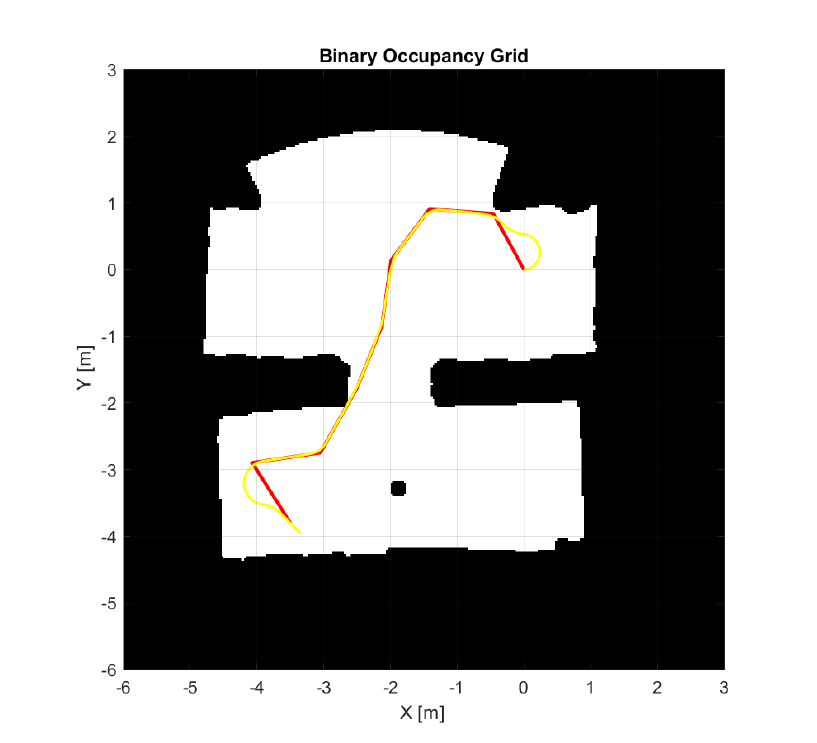
Figure 24. Desired waypoints obtained with HybridA star algorithm and path obtained from odome- try